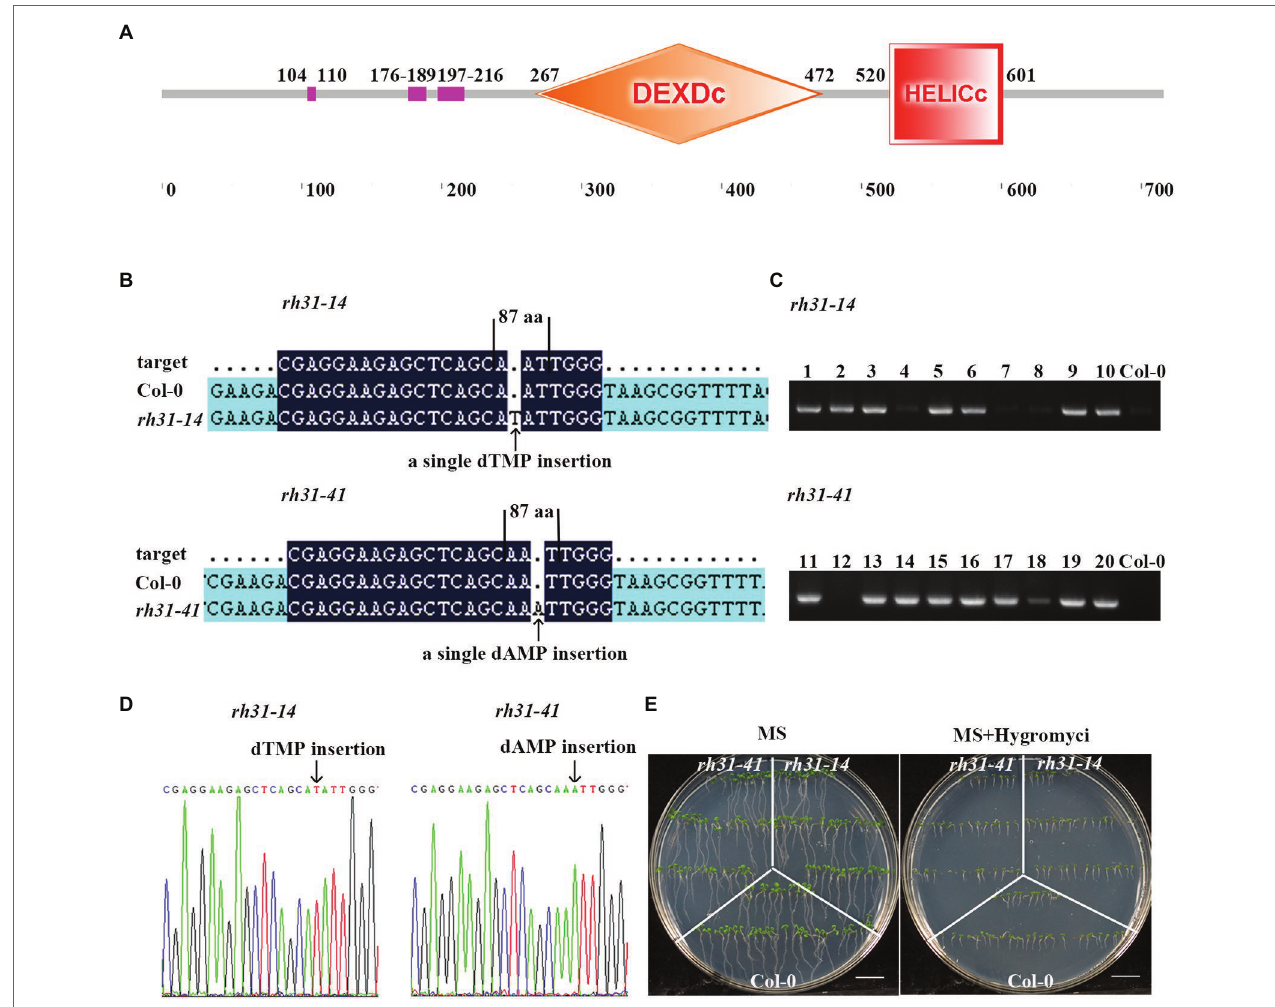
FIGURE 4 | Generation of rh31 mutants. (A) The predicted protein domains of RH31. (B) Schematic of the rh31 insertion mutation. Arrows point to the insertion site. (C) RT-PCR analysis of non-transgenic lines. Col-0 genomic DNA was served as a negative control. Plants 4, 7, 8 of rh31-14 and plant 12 of rh31-41 were non-transgenic, while other plants were Cas9 transgenic. (D) SANGER sequencing chromatography confirming insertion in rh31 mutants. Arrows point to the insertion site. (E) Screening non-Cas9 transgenic plants by hygromycin resistance. The details of target construction and mutant generation are described in the Materials and Methods section. Scale bars = 1